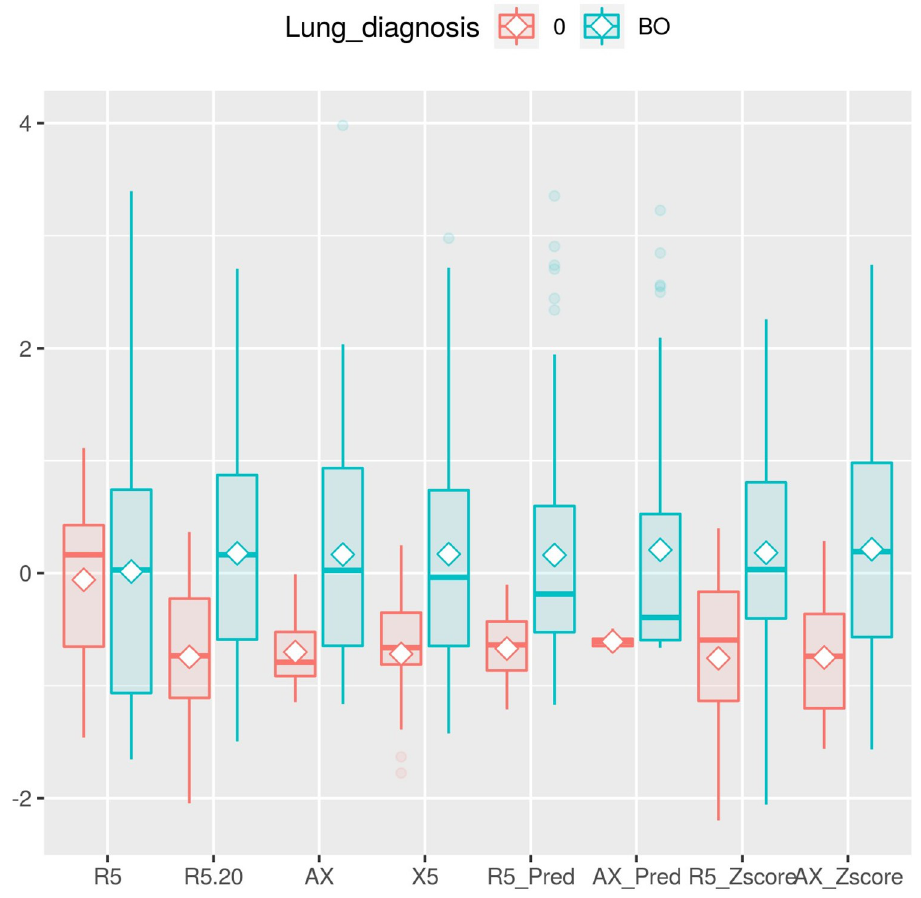
Fig 1. Impulse oscillometry parameters in control and BO groups. For better visualization, the Y-axis values have been rescaled for each unit of the IOS parameter.